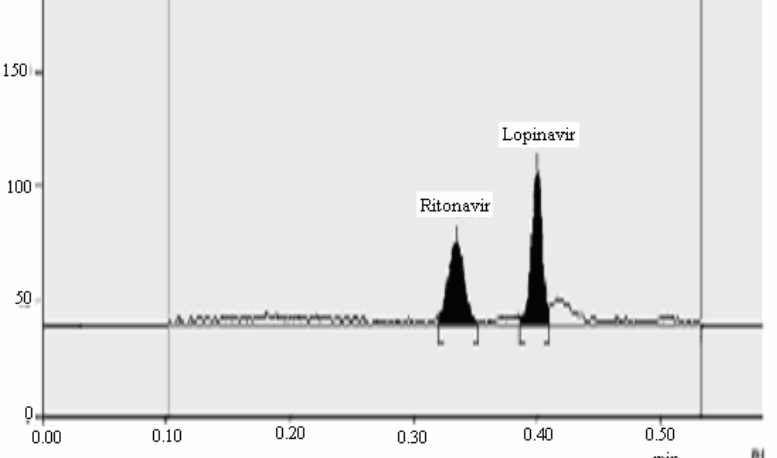
Figure 2. Typical chromatogram showing the separation of (1) Ritonavir and (2)